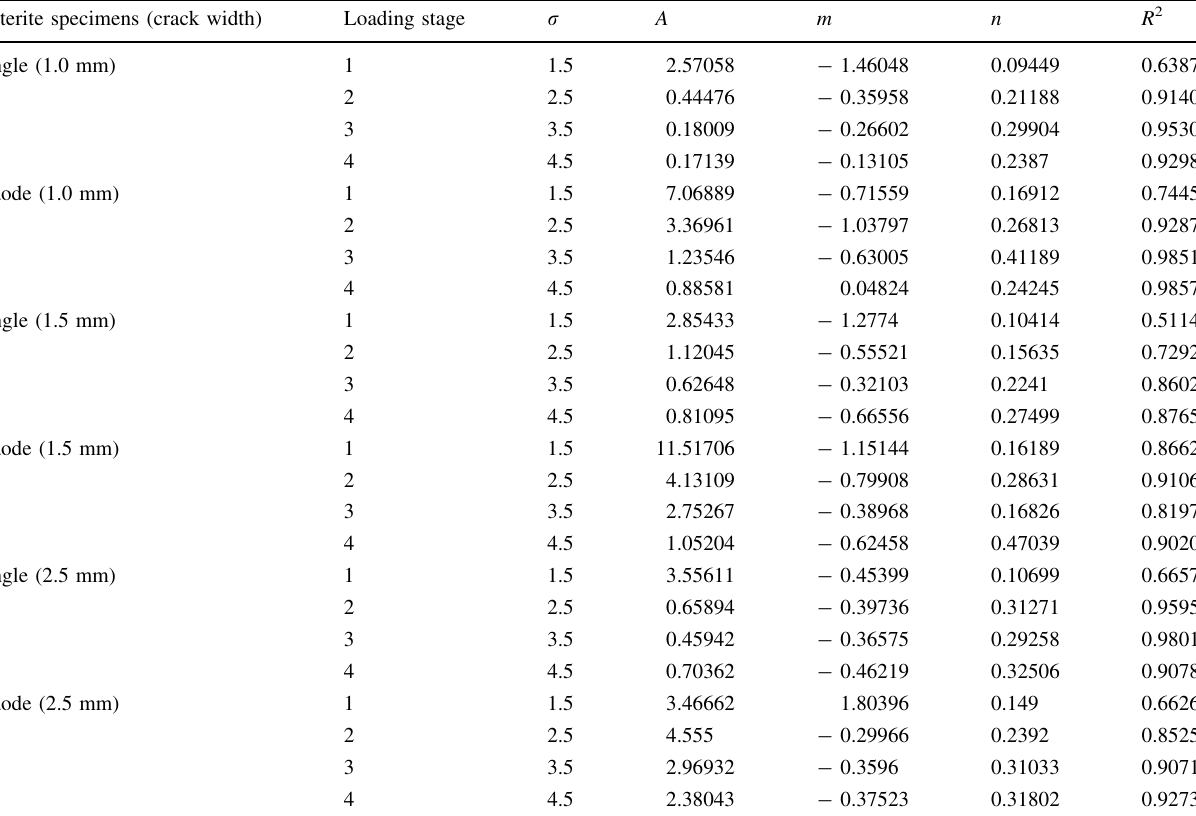
Table 4 Creep parameters under different loads Laterite specimens (crack width) Loading